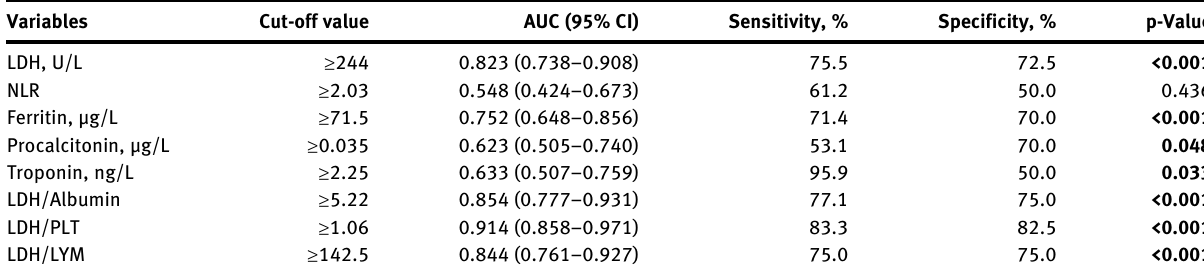
Table  : The value of blood routine parameters in diagnosis of patients with COVID-  B.  .  .  variant group on